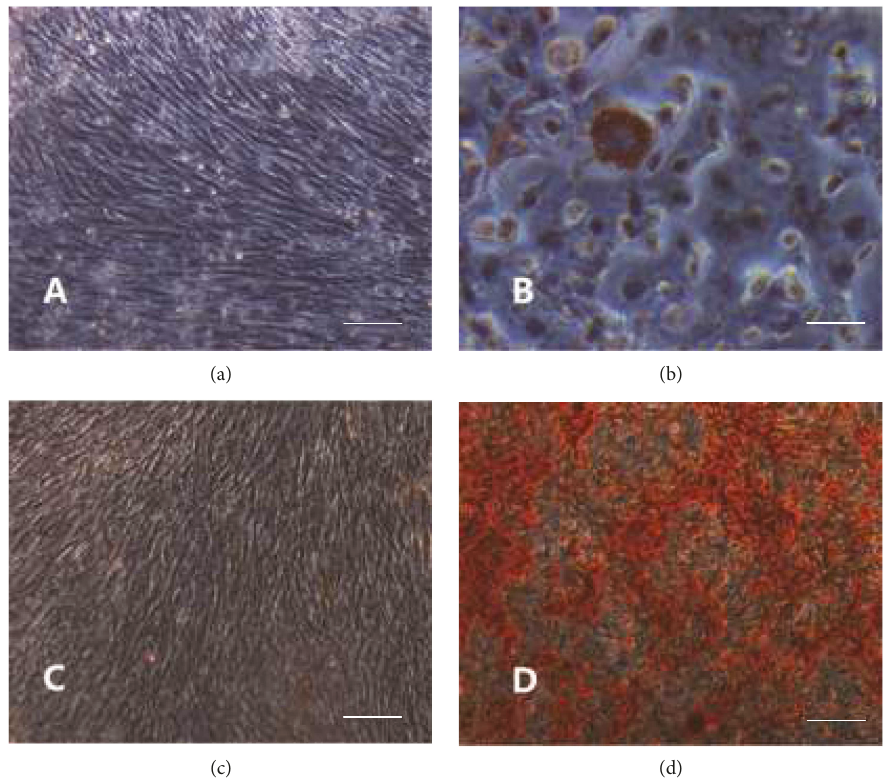
Figure 2: Adipogenic and osteogenic di ff erentiation of UC-MSCs (scale bars=100 μ m): (a) Oil Red O staining of UC-MSCs in the control group, (b) Oil Red O staining of UC-MSCs grown in adipogenic medium, (c) alizarin red staining of UC-MSCs in the control group, and (d) alizarin red staining of UC-MSCs grown in osteogenic medium.